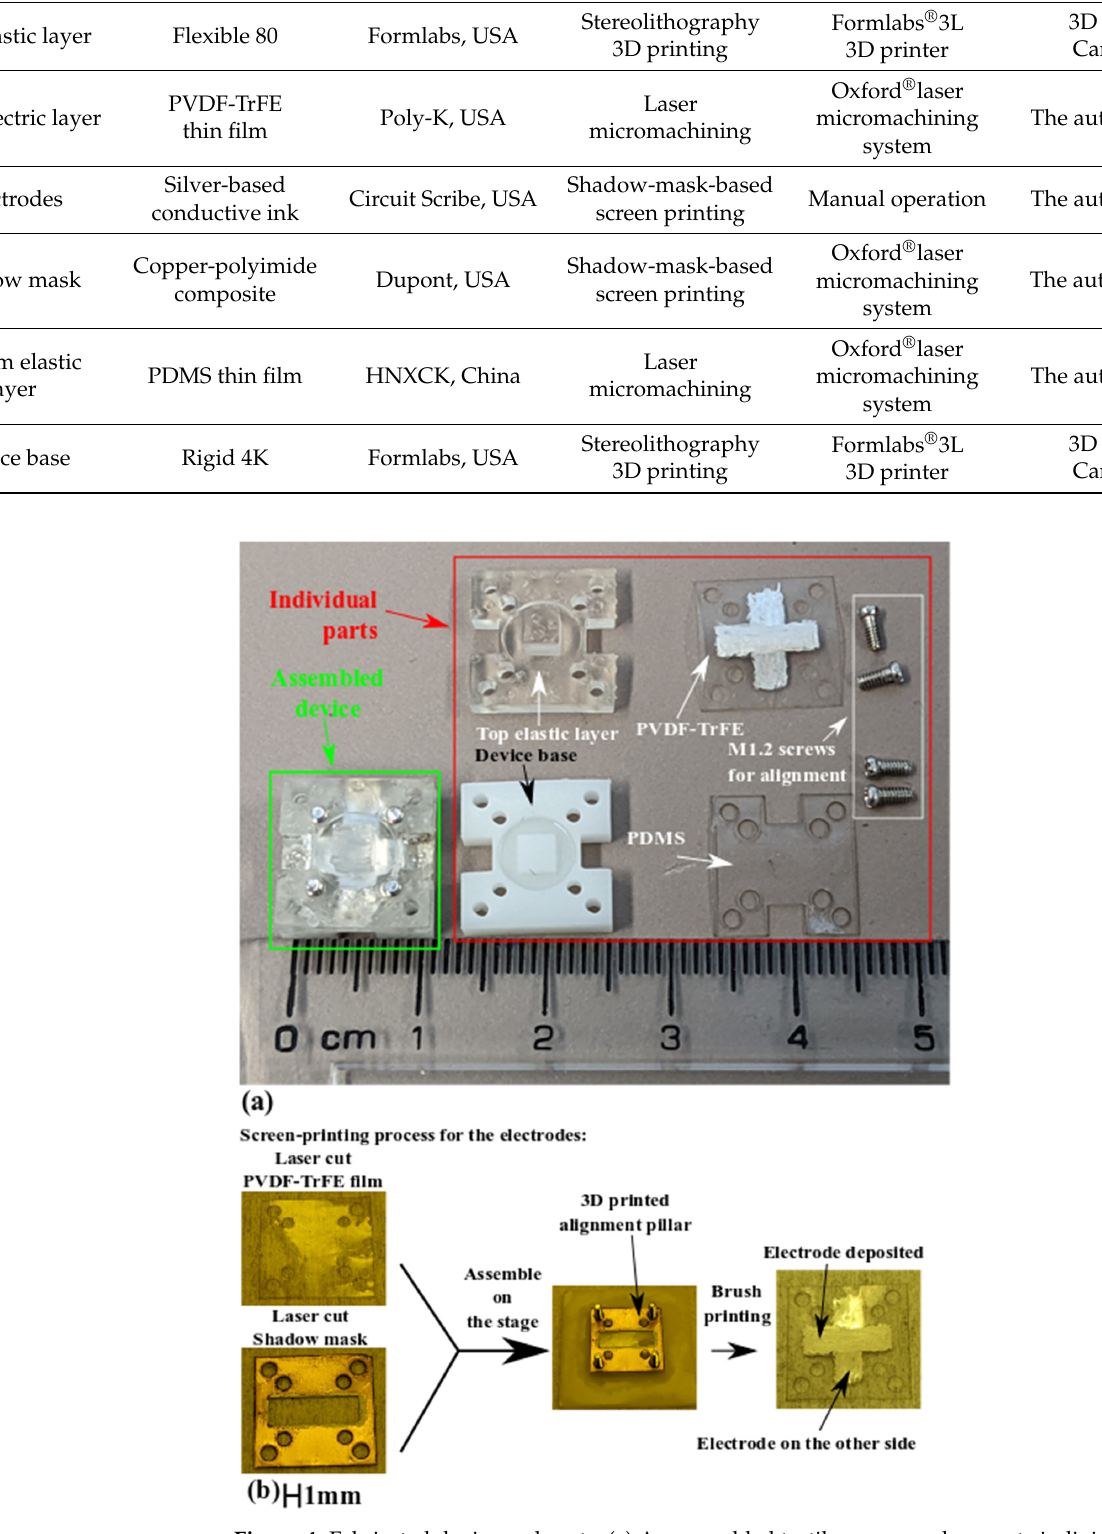
Table 1. Material, equipment, and processes used to fabricate the piezoelectric tactile sensor .